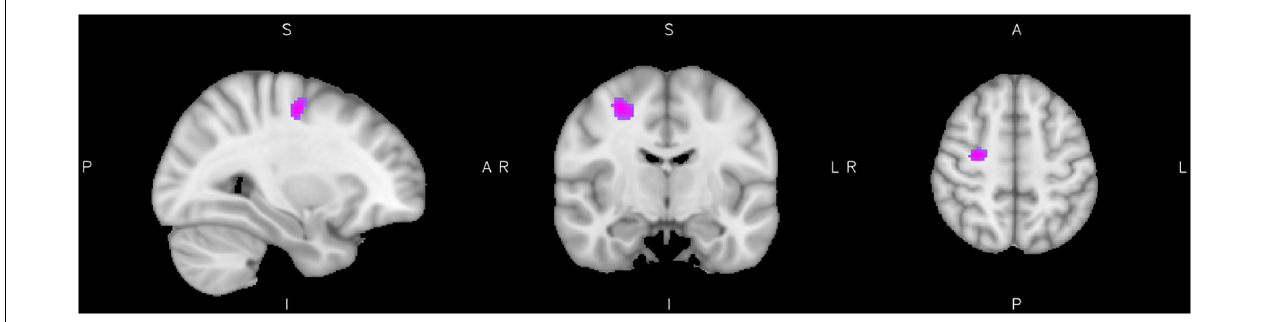
FIGURE 1 | Interaction of diagnosis with reactive aggression. Results from the interaction of reactive aggression and diagnosis at the maximum of the cluster in the precentral gyrus (slices x = 30 left, y = − 10 middle, and z = 52 right), cluster extent corrected for p = 0.05.